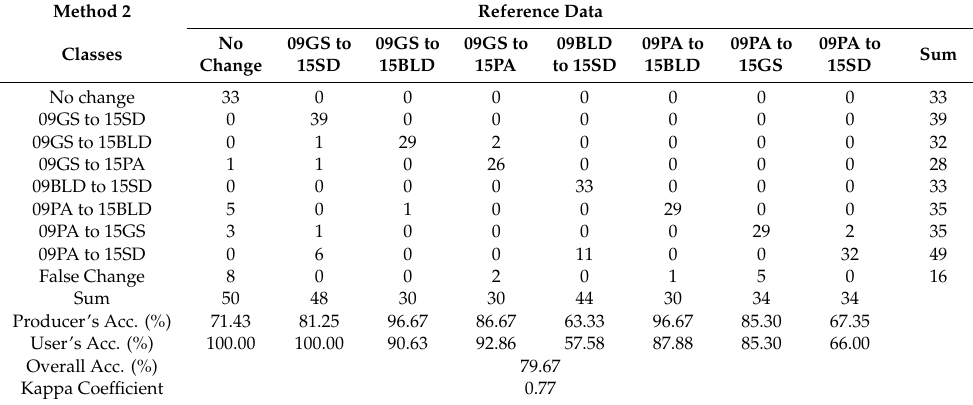
Table 11. The classification accuracies of changes in Method 2.